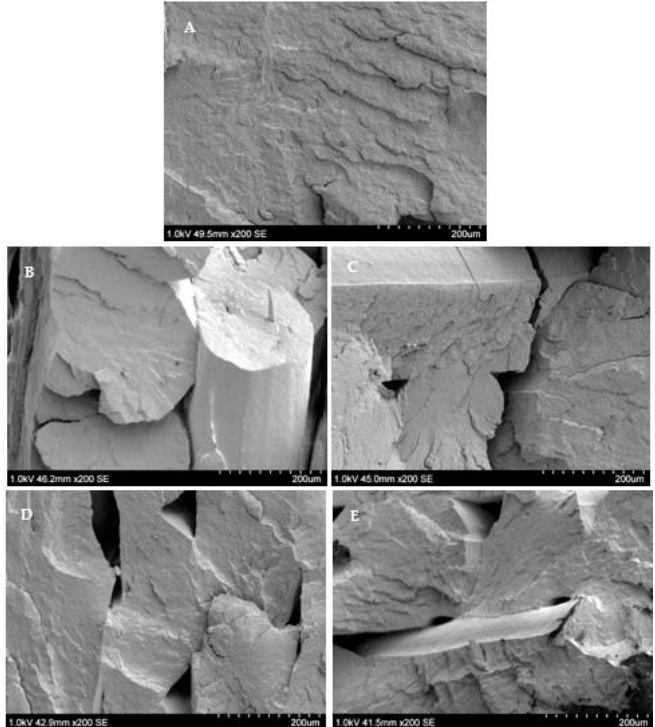
Figure 11. SEM micrographs of Charpy impact 3D printed test specimen fractured surfaces at 22 ◦ C: ( A ) Denotes PHB (55%)/PLA (45%); ( B ) Denotes PHB (55%)/PLA (45%) + 2 wt.% CC; ( C ) Denotes PHB (55%)/PLA (45%) + 4 wt.% CC; ( D ) Denotes PHB (55%)/PLA (45%) + 6 wt.% CC; ( E ) Denotes PHB (55%)/PLA (45%) + 8 wt.%